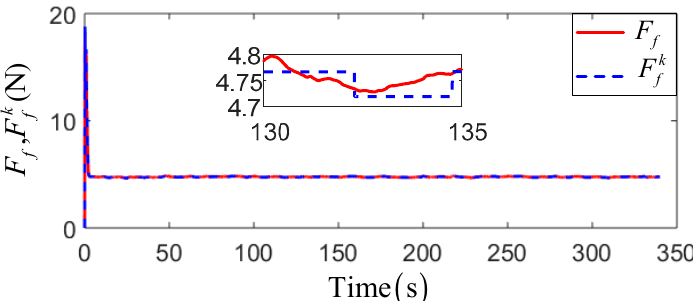
Figure 6. The lift force for the UAV.